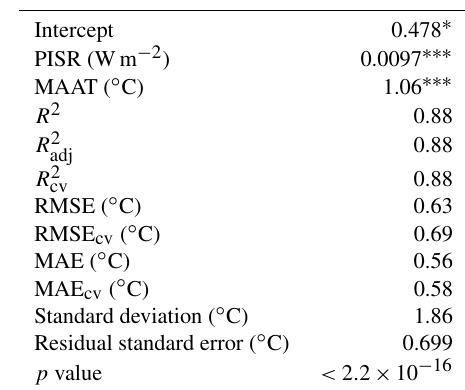
Table 5. Summary statistics of the model. Significance of Wald test: